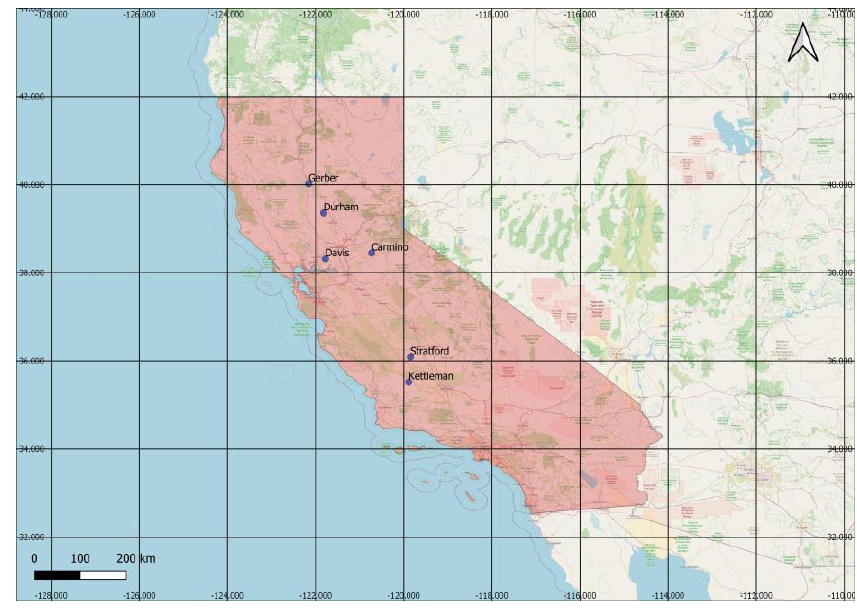
Figure 1. Study area and meteorological stations. Table 1. Information on the selected stations.